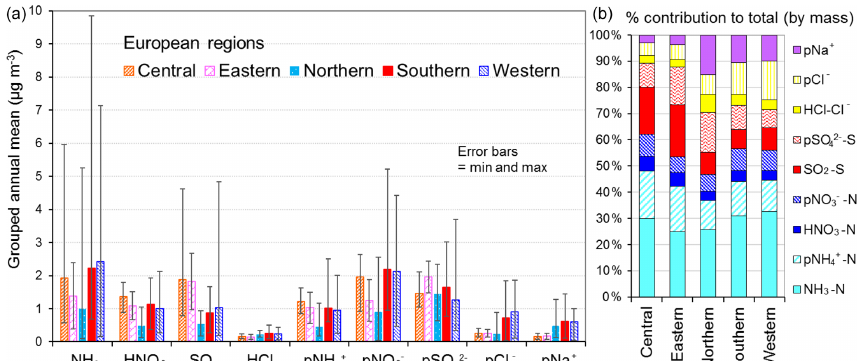
Figure 11. (a) Spatial variation in annual averaged gas and aerosol concentrations (2007 to 2010) measured in the NEU DELTA ® network across Europe, grouped according to geographical distribution of the monitoring sites: central ( n = 17), eastern ( n = 2), northern ( n = 11), southern ( n = 12), and western ( n = 26). The p in front of a component name denotes particulate. (b) Percentage composition of gas and aerosol components according to European